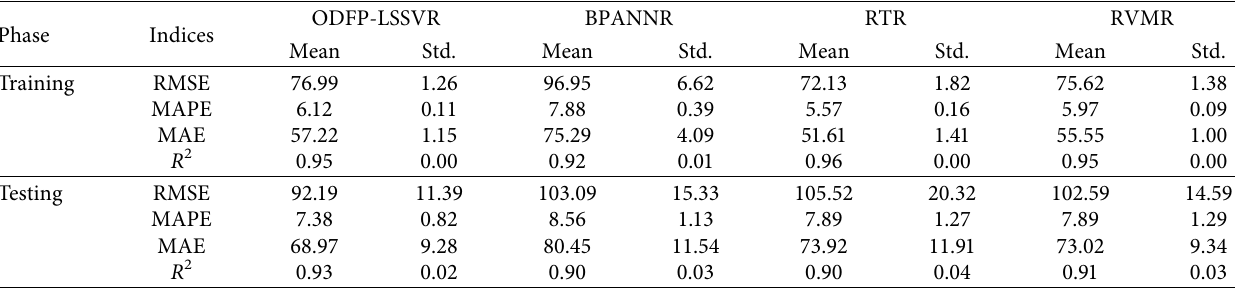
Figure 10: Residual distribution of the model construction phase. Table 3: Prediction result